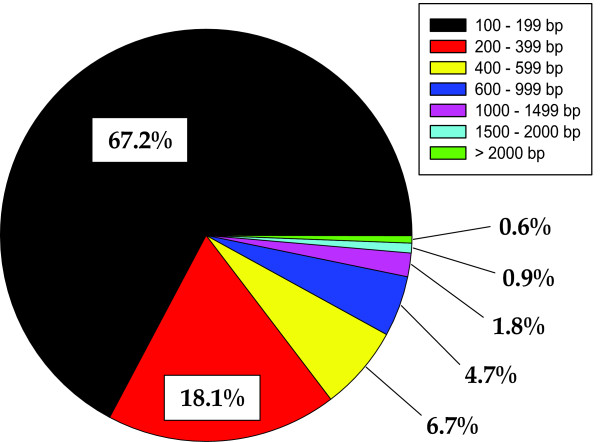
Contigs length distribution. The pie chart shows the percentage of contigs with the length range indicated in the upper legend.